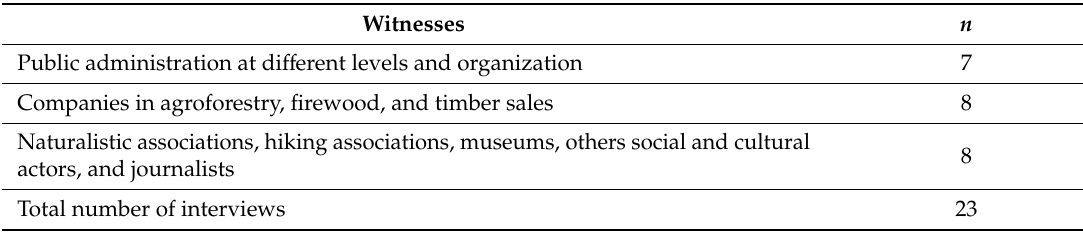
Table 2. Composition of the research